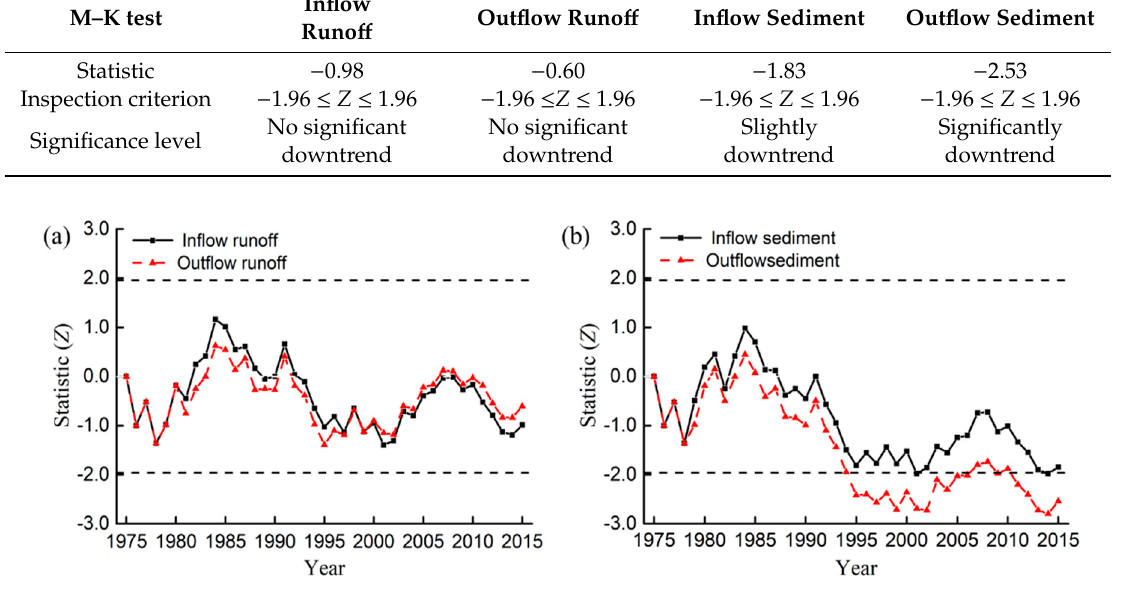
ff M–K statistics series; ( b ) Sediment M–K